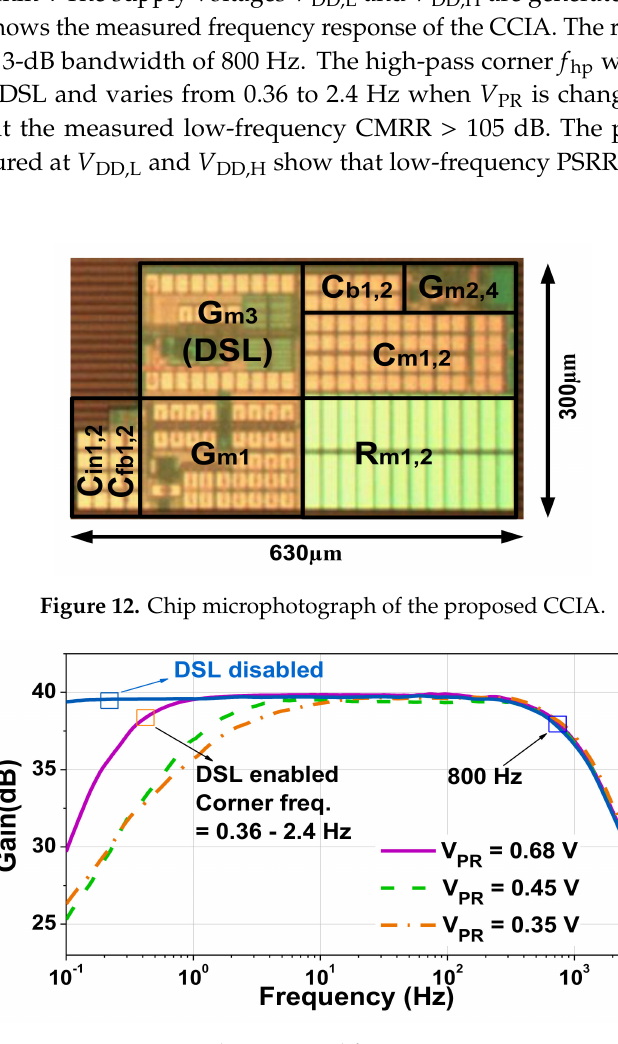
Figure 13. The measured frequency